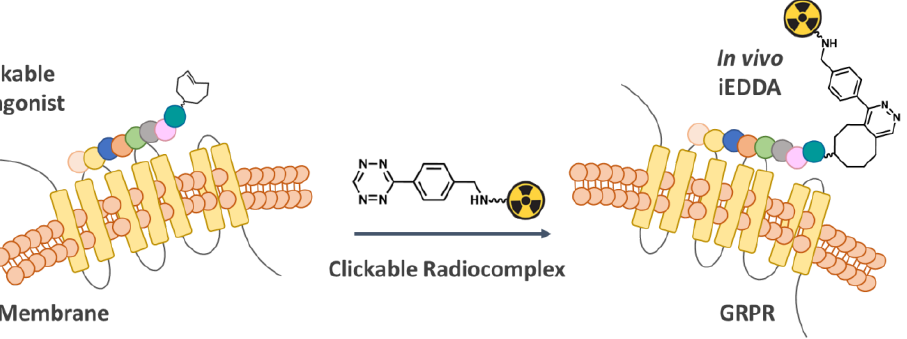
Figure 1. Pretargeting approach to the GRPR using clickable bombesin antagonists and 111 In-radio- complexes.